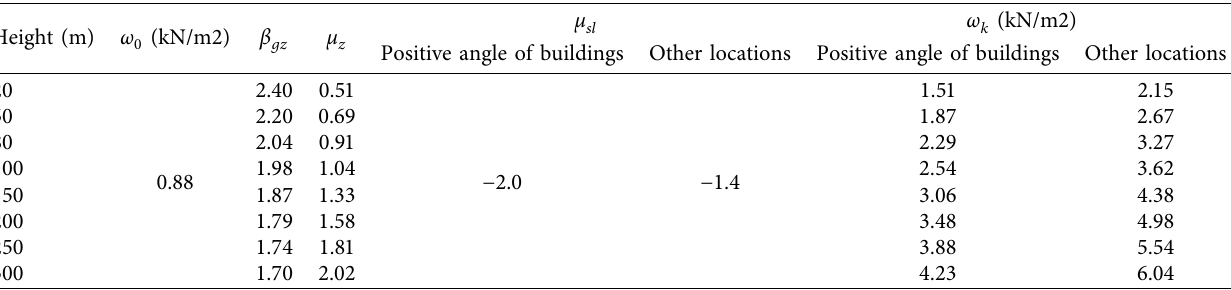
Table 7: The characteristic value of wind load at different heights.